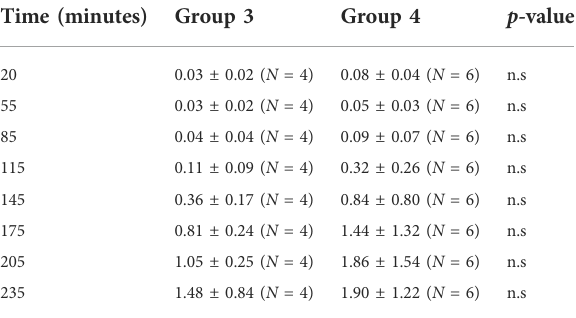
TABLE 1 Urinary ammonium excretion (µmoles.min − 1 Kg. − 1 ) in two groups of rabbits. Group 3 were infused with 5% dextrose, 3% ethanol, and 0.1 M HCl. Group 4 were infused with 5% dextrose, 3% ethanol, 5% mannitol and 0.1 M HCl. A multiple t -test comparison of the two groups showed no signi fi can